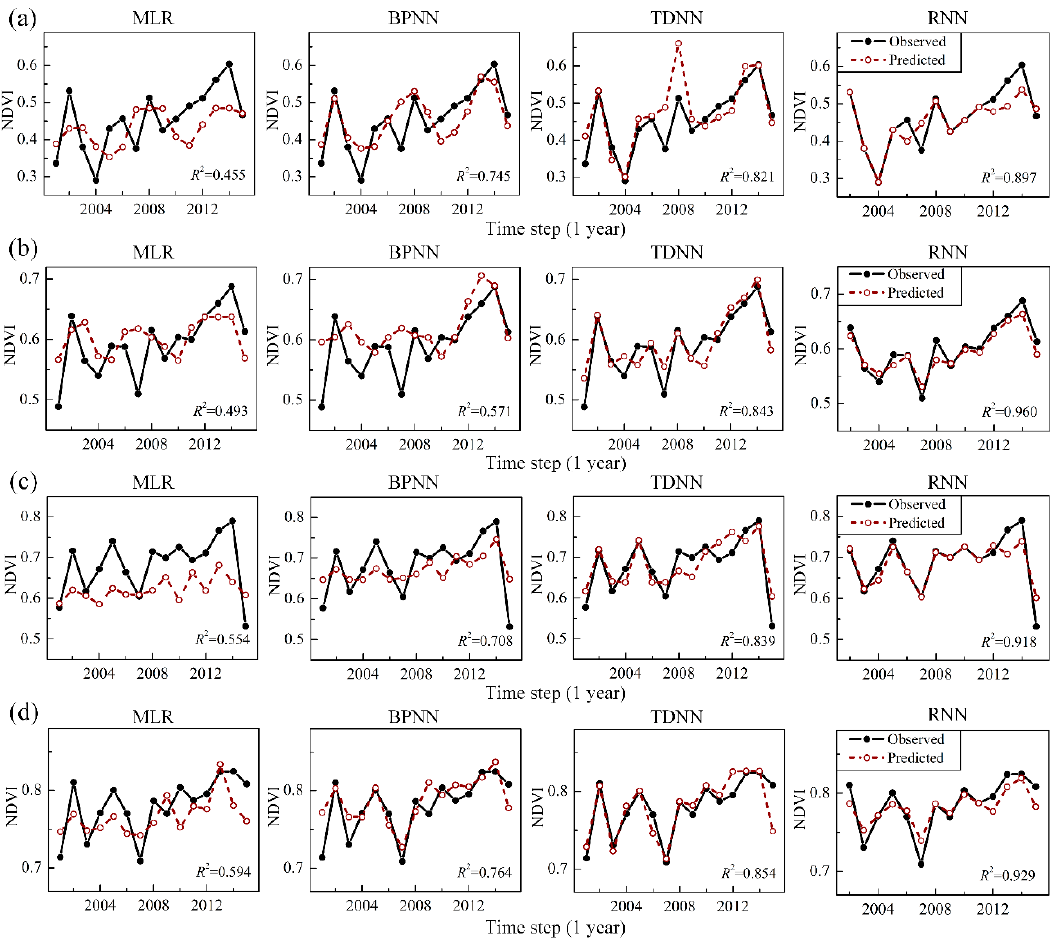
Figure 4. The comparisons of the observed normalized difference vegetation index (NDVI) data and predicted NDVI data for ( a ) A1, ( b ) A2, ( c ) A3 and ( d ) A4 from the multiple linear regression (MLR), BPNN, TDNN and RNN models, respectively. I N ( t − 1), I N ( t − 2) are considered as inputs in the RNN model.